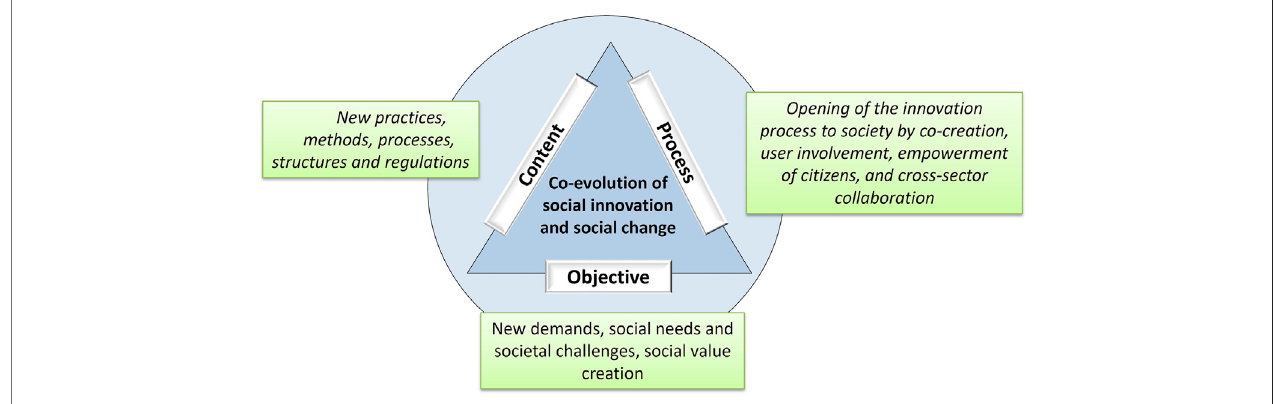
FIGURE 2 | A new innovation paradigm (modi fi ed version of Howaldt et al., 2016, p. 40, permission